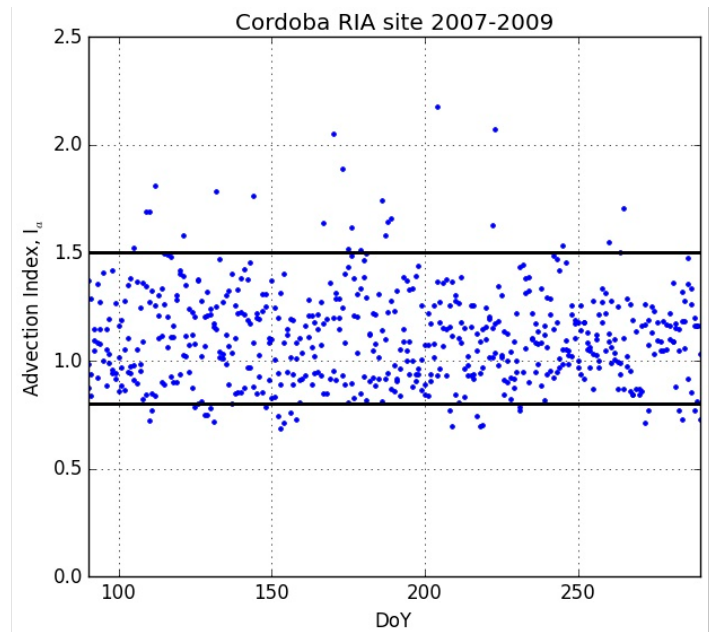
Figure 5. As in Figure 4, but I a is estimated using observations gathered in the RIA station close to Cordoba (in situ observations gathered over non-irrigated surface).